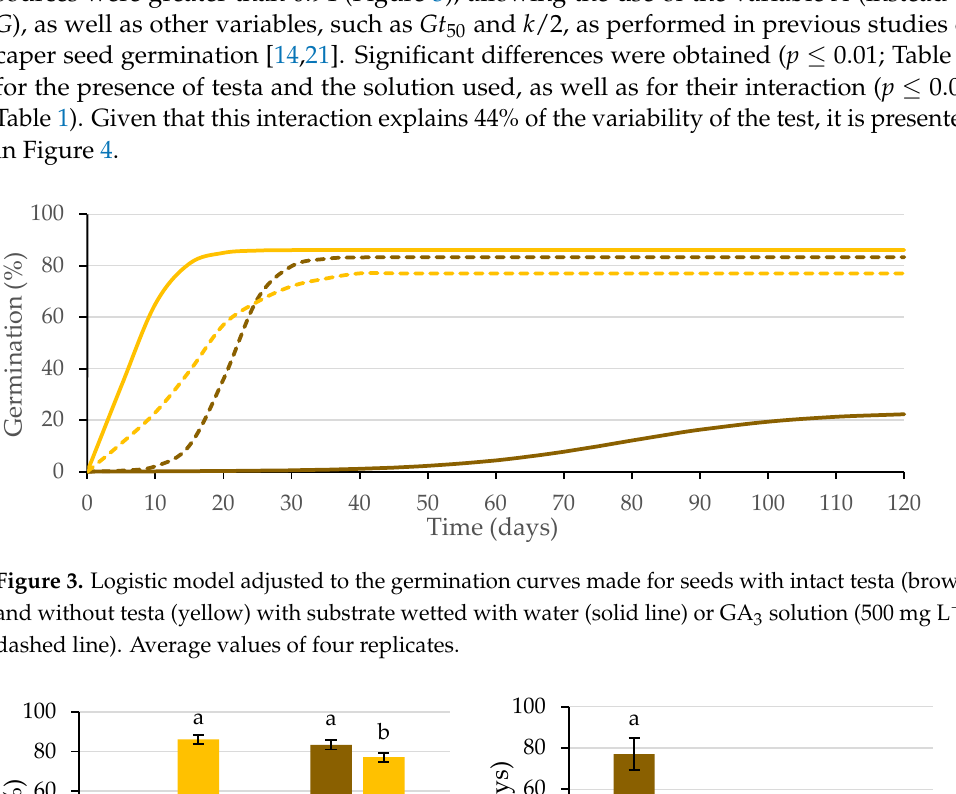
Figure 4. Analysis of the significant interactions of the analysis of variance in Table 1 between the presence of the testa (with testa (brown) and without testa (yellow)) and the solution used to wet the substrate (water (W) or GA3) on the final germination ( A ) and the number of days needed to reach 50% of the final germination ( Gt 50 ). Average values of four replicates. Different letters indicate significant differences according to the LSD test. Error bars represent the LSD ( p ≤ 0.05).